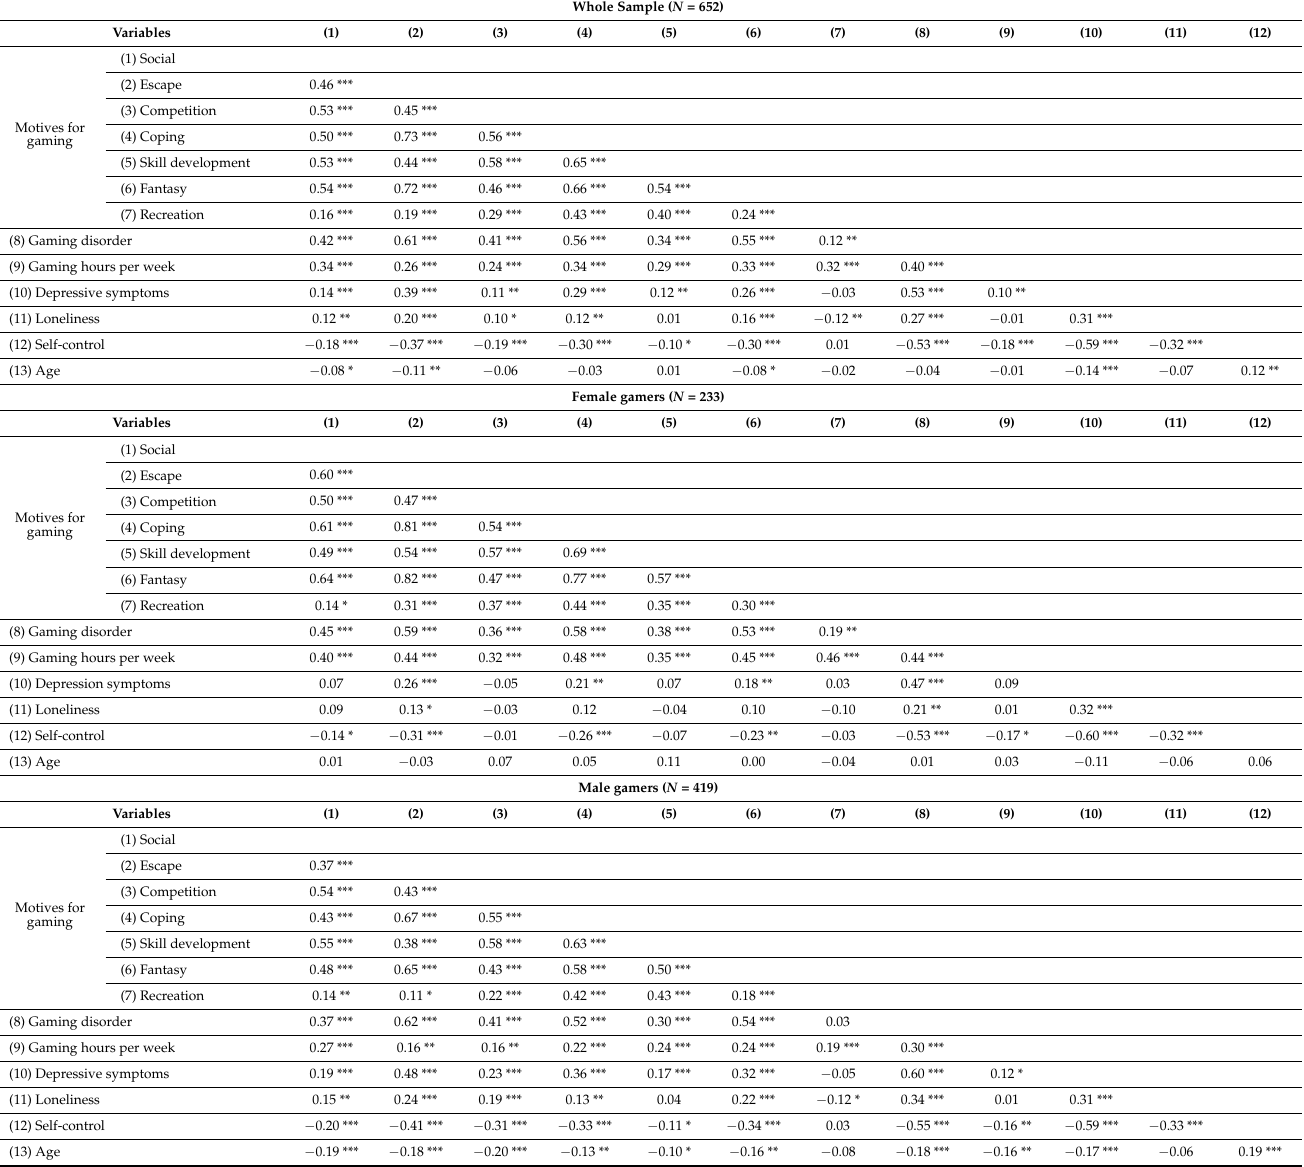
Table 3. Correlation analysis results